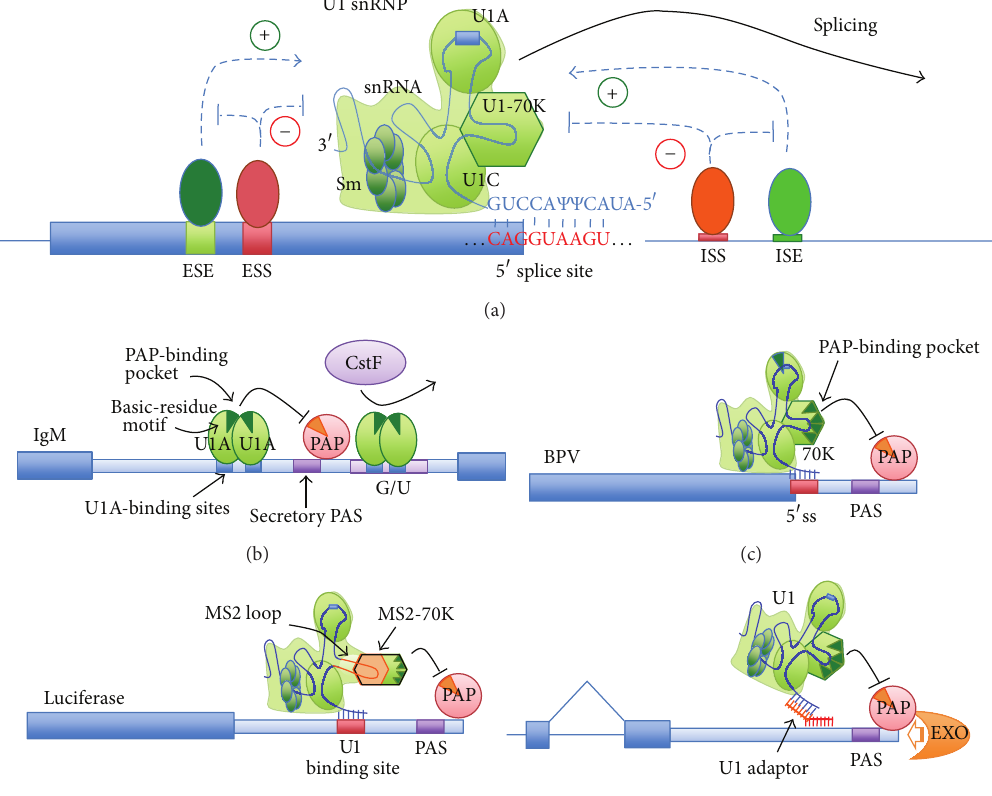
Figure 1: Modes of U1 snRNP activity in splicing and suppression of 3 󸀠 end processing. (a) Role of U1 snRNP in splicing. The 5 󸀠 end of U1 snRNA base-pairs to the 5 󸀠 splice site cotranscriptionally, to define the functional splice donor site. The process is positively and negatively modulated by splicing factors binding to exonic and intronic splicing enhancer and silencers (ESE, ISE, ESS, and ISS, resp.). (b) Role of U1A protein in suppression of IgM cleavage and polyadenylation. U1 snRNP component U1A binds to multiple motifs (blue boxes) upstream or downstream of the intronic PAS (purple box) in IgM C 𝜇4 = M 1 intron. These sites contain the A(U/G)GCN 1−3 C consensus motif and are similar to U1A-binding site on U1 snRNA. From the upstream sites, U1A multimers interact directly with the C-terminal domain of PAP through a binding pocket formed by the basic-residue motifs (green triangles), blocking polyadenylation. When U1A binds downstream, it prevents CstF binding to the G/U element (light purple box) and thus interferes with cleavage. (c) Role of U1 snRNP in suppression of BPV polyadenylation. U1 binds to a 5 󸀠 ss a few nucleotides upstream of the alternative PAS. Like U1A multimers, U1-70K interacts directly with the C-terminal domain of PAP through a binding pocket formed by the basic-residue motifs, blocking polyadenylation. (d) Tethered U1-70 K suppresses polyadenylation. A modified U1-MS2 snRNA is engineered to contain an MS2-binding loop in place of the U1-70 K binding loop. A U1-binding site represses polyadenylation and expression from a luciferase reporter vector when the wt U1 snRNA is expressed. The mutant U1-MS2 snRNA recapitulates PAP inhibition only when a fusion MS2-70K protein is also coexpressed. (e) U1 adaptors recruit U1 snRNP to suppress polyadenylation. Single-stranded, bifunctional modified ASOs are used to recruit endogenous U1 to target sites within ∼ 1Kb region upstream of a PAS. The targeting moiety (red) base-pairs to a unique, transcript-specific sequence, while the recruiting moiety contains a consensus 5 󸀠 ss sequence to bind U1 snRNP with high affinity. The tethered U1 snRNP suppresses polyadenylation and the mRNA is then degraded by the 3 󸀠 -5 󸀠 exosome. Large blue boxes represent exons/coding regions.